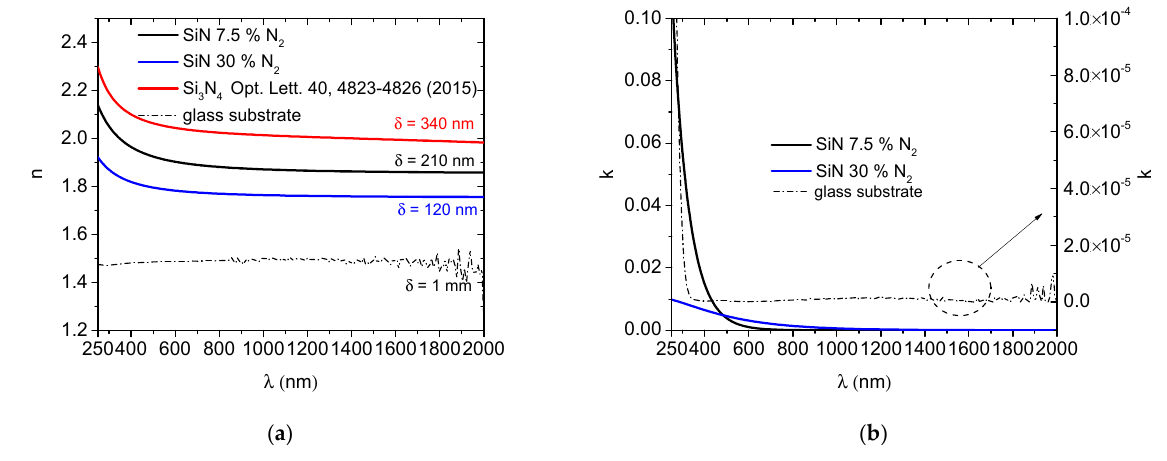
Figure 10. Experimental n ( a ) and k ( b ) parameters for SiN x layers for three different conditions.